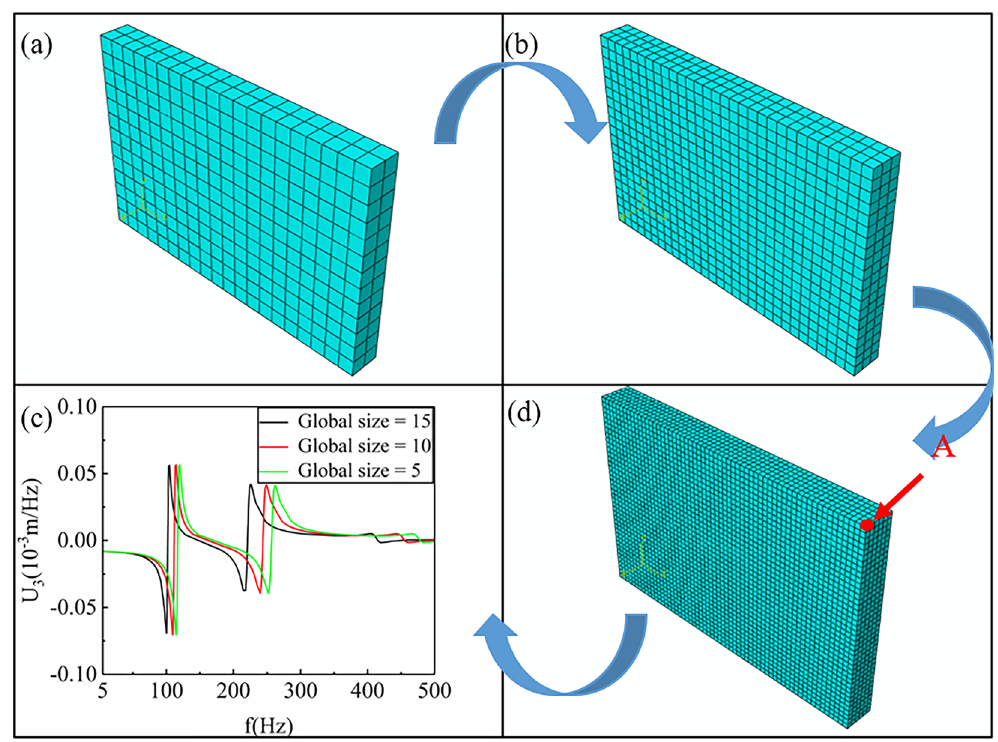
Figure 2. Convergence test and schematic diagram of the finite element model. ( a ) Global size = 15, ( b ) Global size = 10, ( c ) Convergence test, ( d ) Global size = 5.